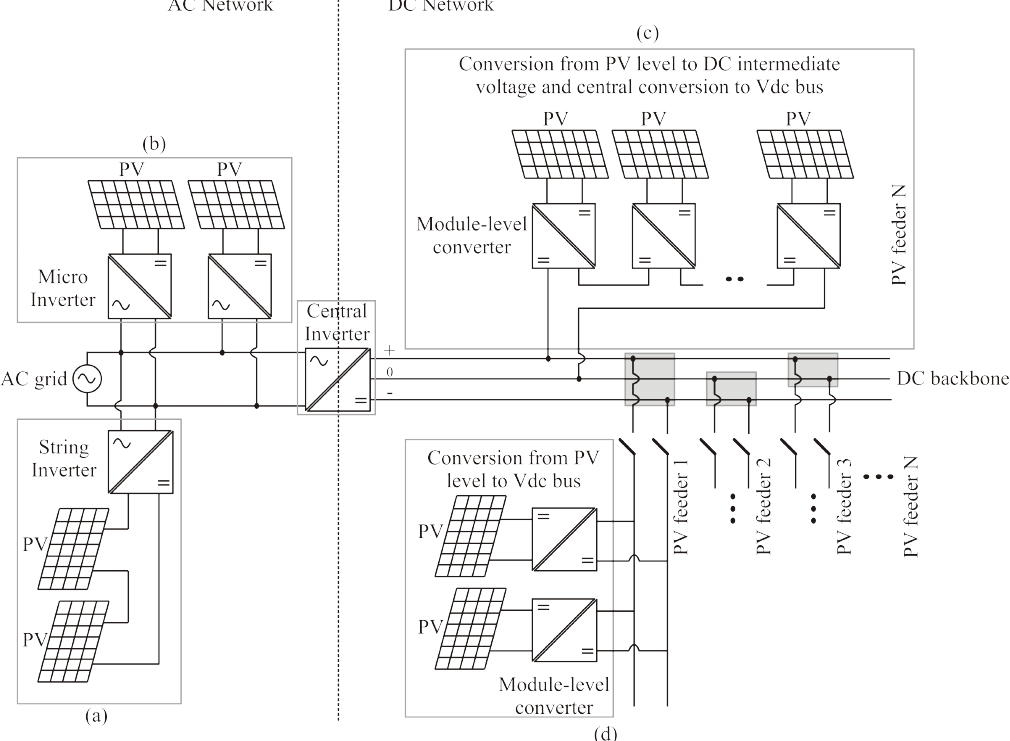
Figure 1. The possible electrical architectures for PV module interconnection to an AC or DC grid: ( a ) string inverters; ( b ) micro-inverters; ( c ) series power optimizer; and ( d ) parallel power